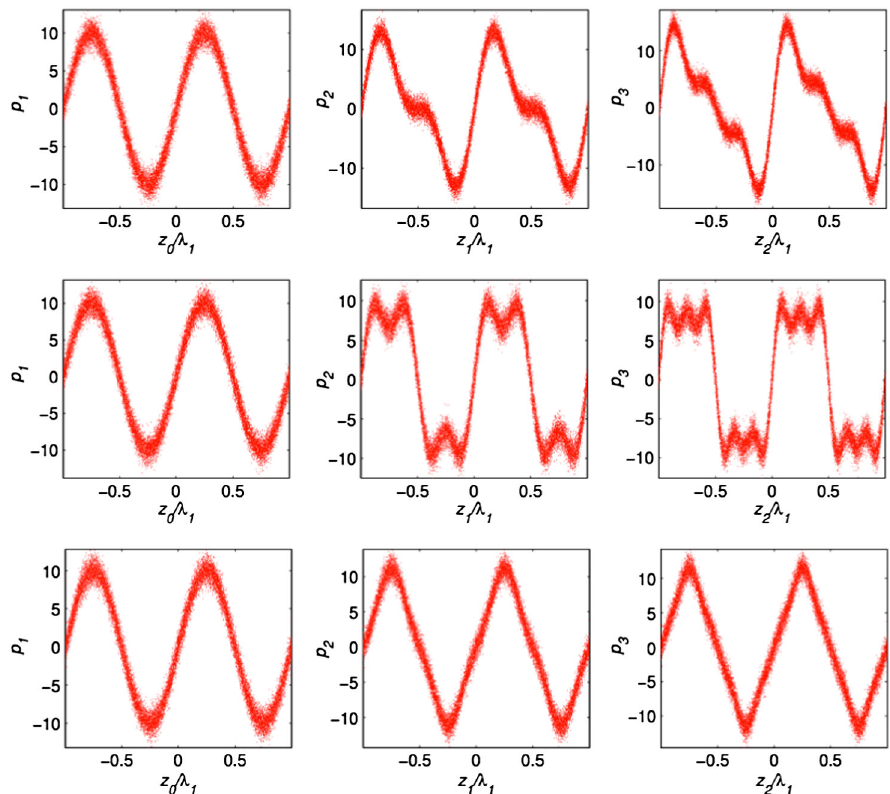
FIG. 2. Waveform generation through harmonic modulation. Different waveforms are shown in independent rows. The left column is the modulation by one laser, the middle column is with two lasers, and the right column is with three lasers. Top: Sawtooth wave generation with modulations of wavelengths (cid:6) 1 , (cid:6) 2 ¼ (cid:6) 1 = 2 , and (cid:6) 3 ¼ (cid:6) 1 = 3 . Here A 1 ¼ 10 , A 2 ¼ A 1 = 2 , A 3 ¼ A 1 = 3 , B 1 ¼ B 2 ¼ 0 , (cid:3) 2 ¼ (cid:3) 3 ¼ 0 . Middle: Square wave generation with (cid:6) 2 ¼ (cid:6) 1 = 3 , (cid:6) 3 ¼ (cid:6) 1 = 5 , A 1 ¼ 10 , A 2 ¼ A 1 = 3 , A 3 ¼ A 1 = 5 , B 1 ¼ B 2 ¼ 0 , (cid:3) 2 ¼ (cid:3) 3 ¼ 0 . Bottom: Triangle wave with (cid:6) 2 ¼ (cid:6) 1 = 3 , (cid:6) 3 ¼ (cid:6) 1 = 5 , A 1 ¼ 10 , A 2 ¼ A 1 = 9 , A 3 ¼ A 1 = 25 , B 1 ¼ B 2 ¼ 0 , (cid:3) 2 ¼ (cid:1) , and (cid:3) 3 ¼ 0